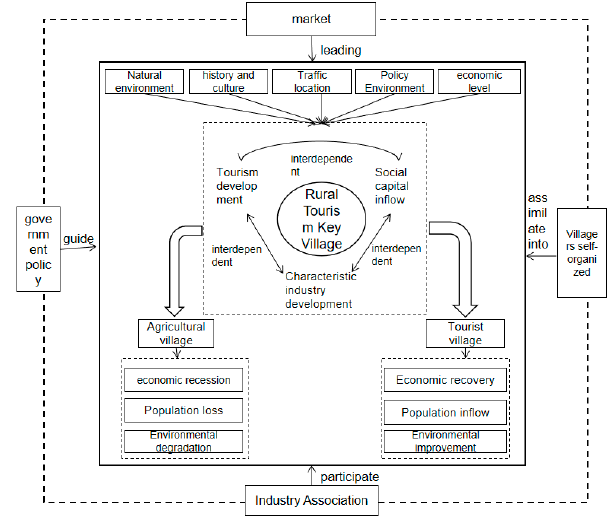
Figure 9. Rural transformation mechanism driven by tourism.